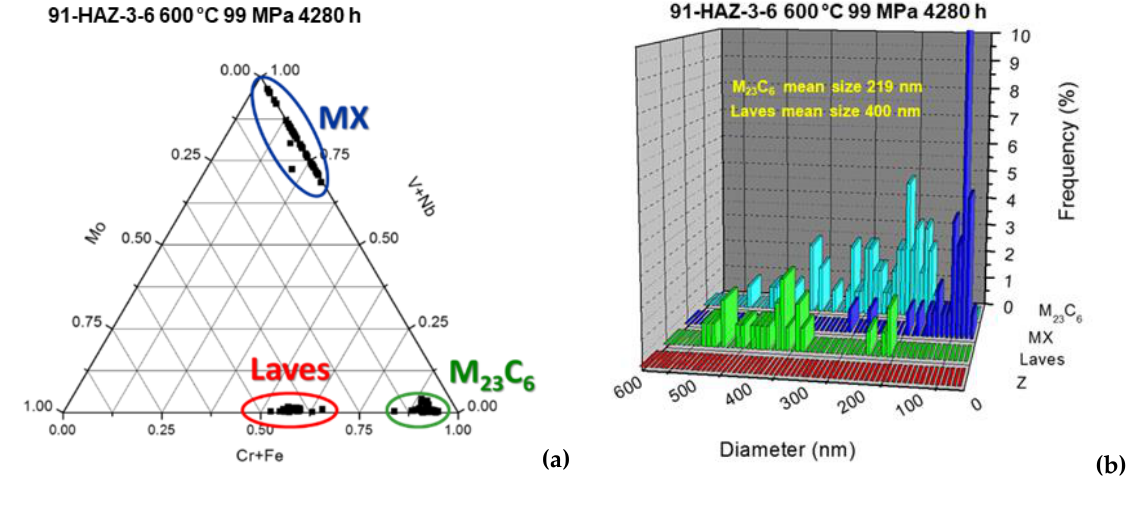
Figure A8. Failed crept cross-weld specimen 91-HAZ-3-6 600 °C 99 MPa 4280 h (sample C). Ternary diagram ( a ) and size distribution ( b ) (TEM analysis).